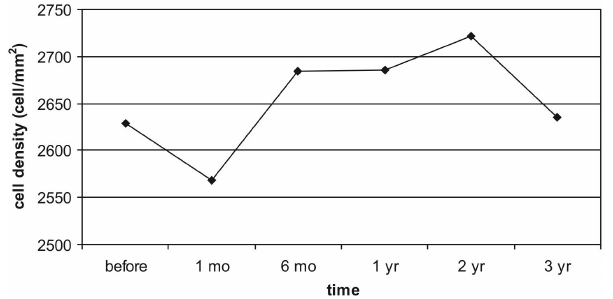
Fig. 3. The °uctuation of cell density in Group 2. The cell density slightly decreased in the ¯rst month. However, this phenomenon did not persist after 6 months.